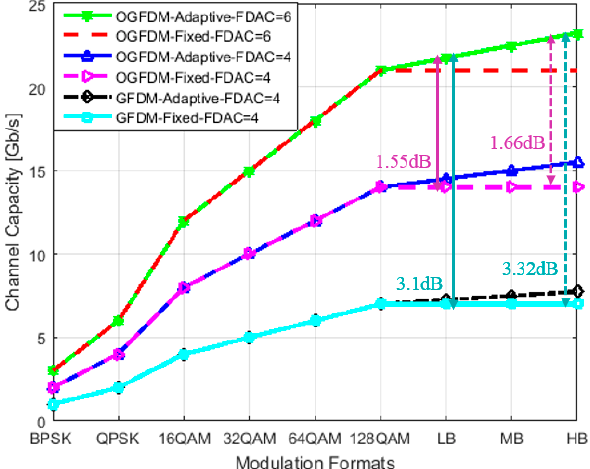
Figure 9. Channel capacity of the multi-carrier OGFDM vs. GFDM with adaptive modulations and F DAC = 4 and 6 GHz.